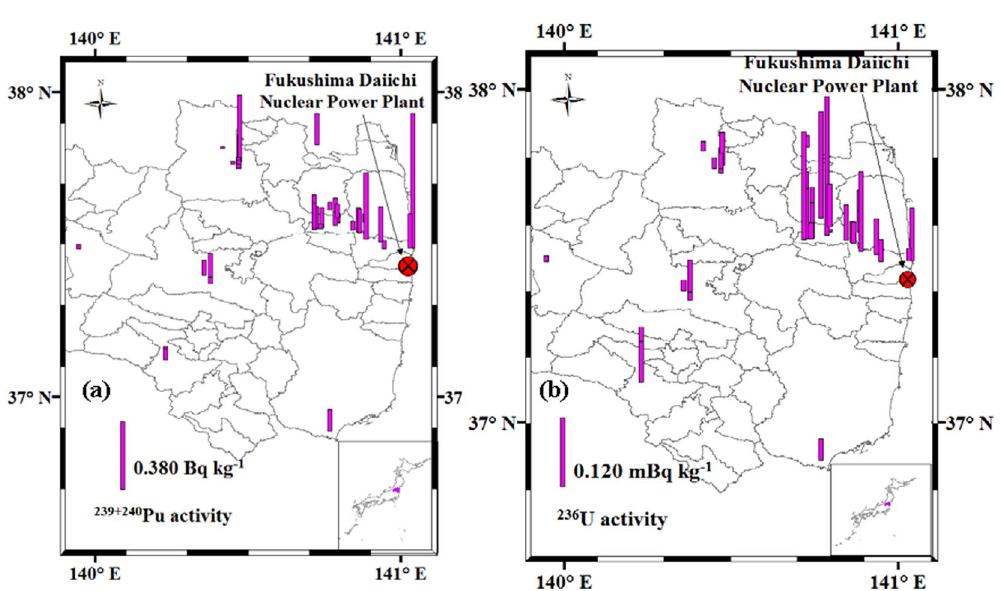
Figure 5. 236 U and 239 + 240 Pu activity distributions in soil samples collected in Fukushima Prefecture immediately after the FDNPP accident. This map was prepared with Arc GIS 10.3